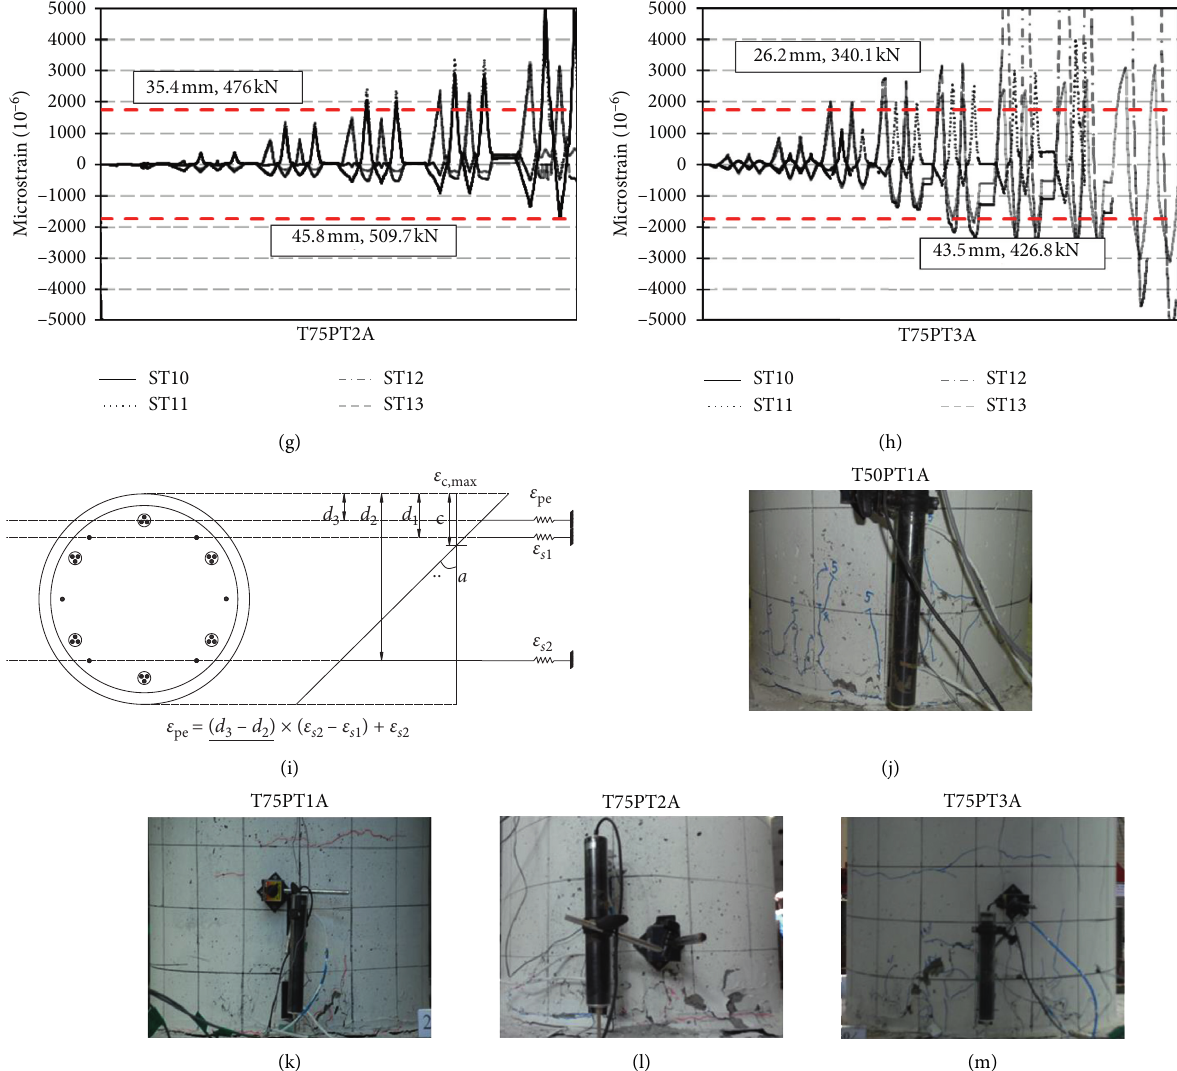
Figure 7: Evaluation according to seismic performance levels. (a) Performance level 1 T50PT1A. (b) Performance level 1 T75PT1A. (c) Performance level 1 T75PT2A. (d) Performance level 1 T75PT3A. (e) Performance level 2 T50PT1A for reinforcement. (f) Performance level 2 T75PT1A for reinforcement. (g) Performance level 2 T75PT2A for reinforcement. (h) Performance level 2 T75PT3A for reinforcement. (i) Performance level 2 for tendon. (j) Performance level 3 T50PT1A. (k) Performance level 3 T75PT1A. (l) Performance level 3 T75PT2A. (m) Performance level 3 T75PT3A.